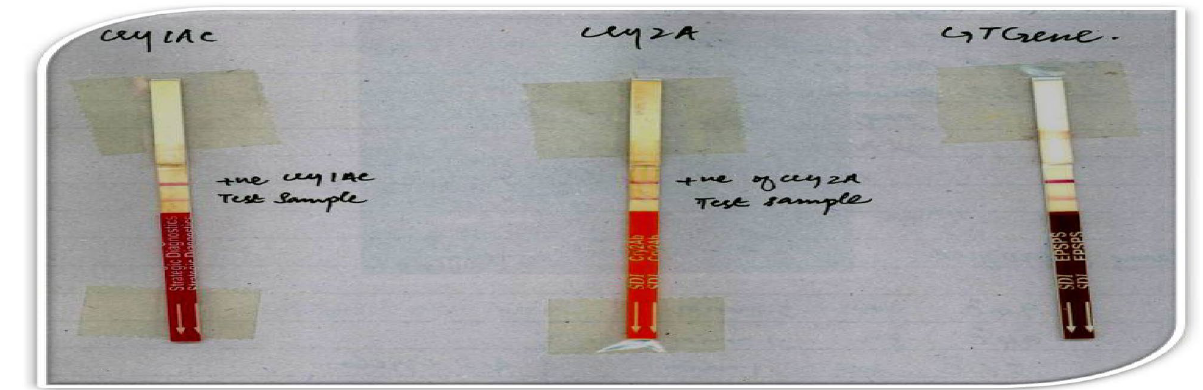
Figure 8. ELISA-Dipstick assay for the expression confirmation of three trans-proteins CEMB- Cry 1Ac, CEMB- Cry 2A and CEMB-GTGene in V 0 -generation. Lane 1: ELISA-Dipstick Positive for CEMB- Cry 1Ac transgenic plants. Lane 2: ELISA-Dipstick Positive for CEMB- Cry 2A transgenic plants. Lane 3: ELISA-Dipstick Positive for CEMB-GTGene transgenic